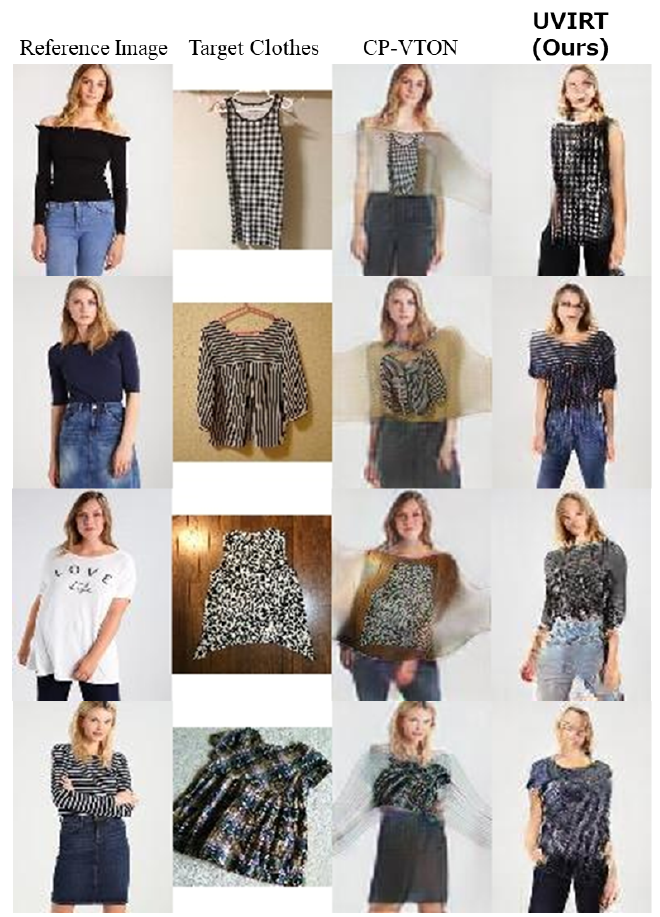
Figure 4. Qualitative comparison of Proposed UVIRT vs. CP-VTON on the test images of the C2C market dataset. CP-VTON cannot warp the unaligned clothing to the persons well. On the other hand, our UVIRT can warp the unaligned images to the person because of disentangling the person and the clothing features in the latent